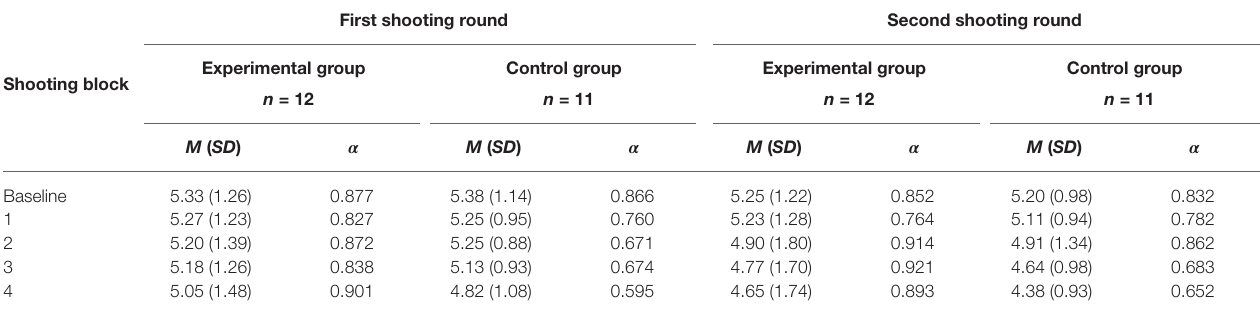
TABLE 2 | Means ( M ), standard deviations ( SD ), and internal consistencies (Cronbach’s α ) of the German 5-Item Brief State Self-Control Capacity Scale (SMS-5; Lindner et al., 2019) for each shooting block during the first and second shooting rounds. First shooting